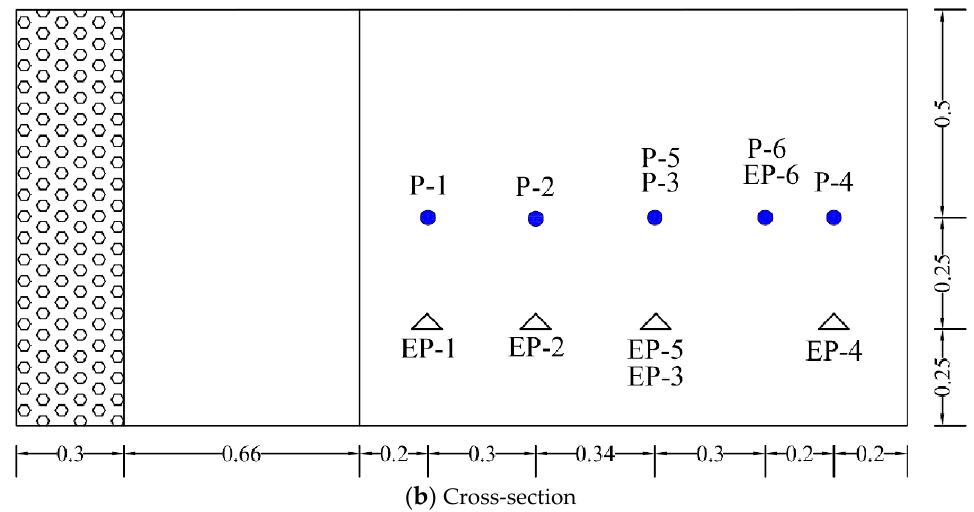
Figure 5. Model test of silt slope osmometer, earth pressure box buried location map (m).